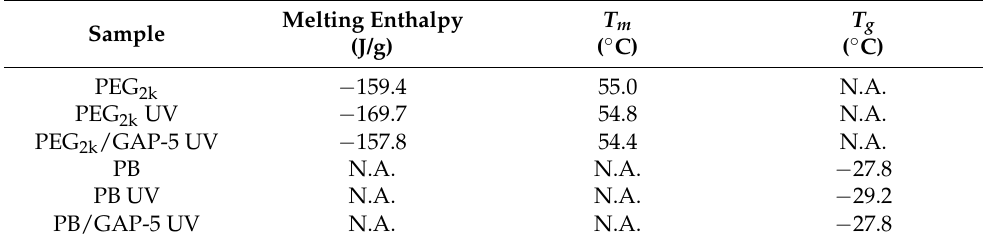
Table 2. DSC results of PEG and PB samples before and after crosslinking for 2 h.